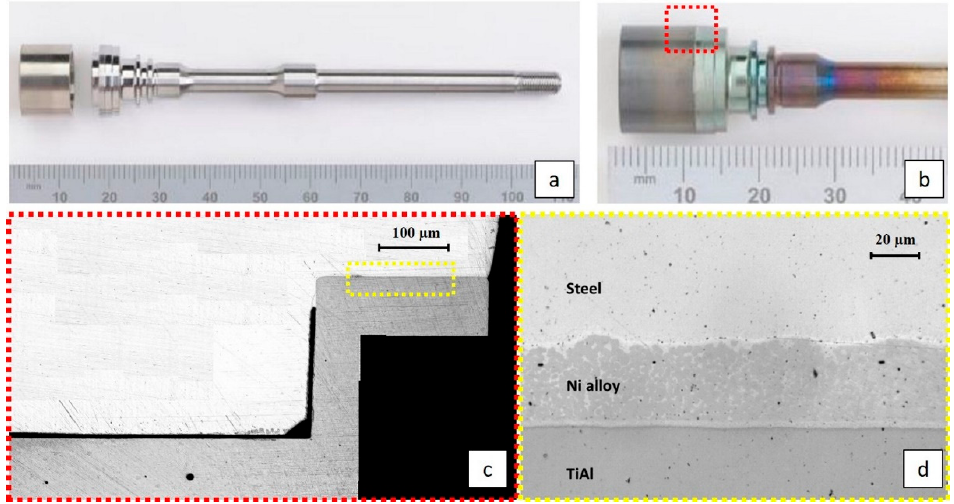
Figure 1. ( a ) TiAl cylinder and Steel shaft before the assembly; ( b ) TiAl cylinder and steel shaft after the assembly; ( c ) longitudinal section of the joint; ( d ) optical microscope image of the